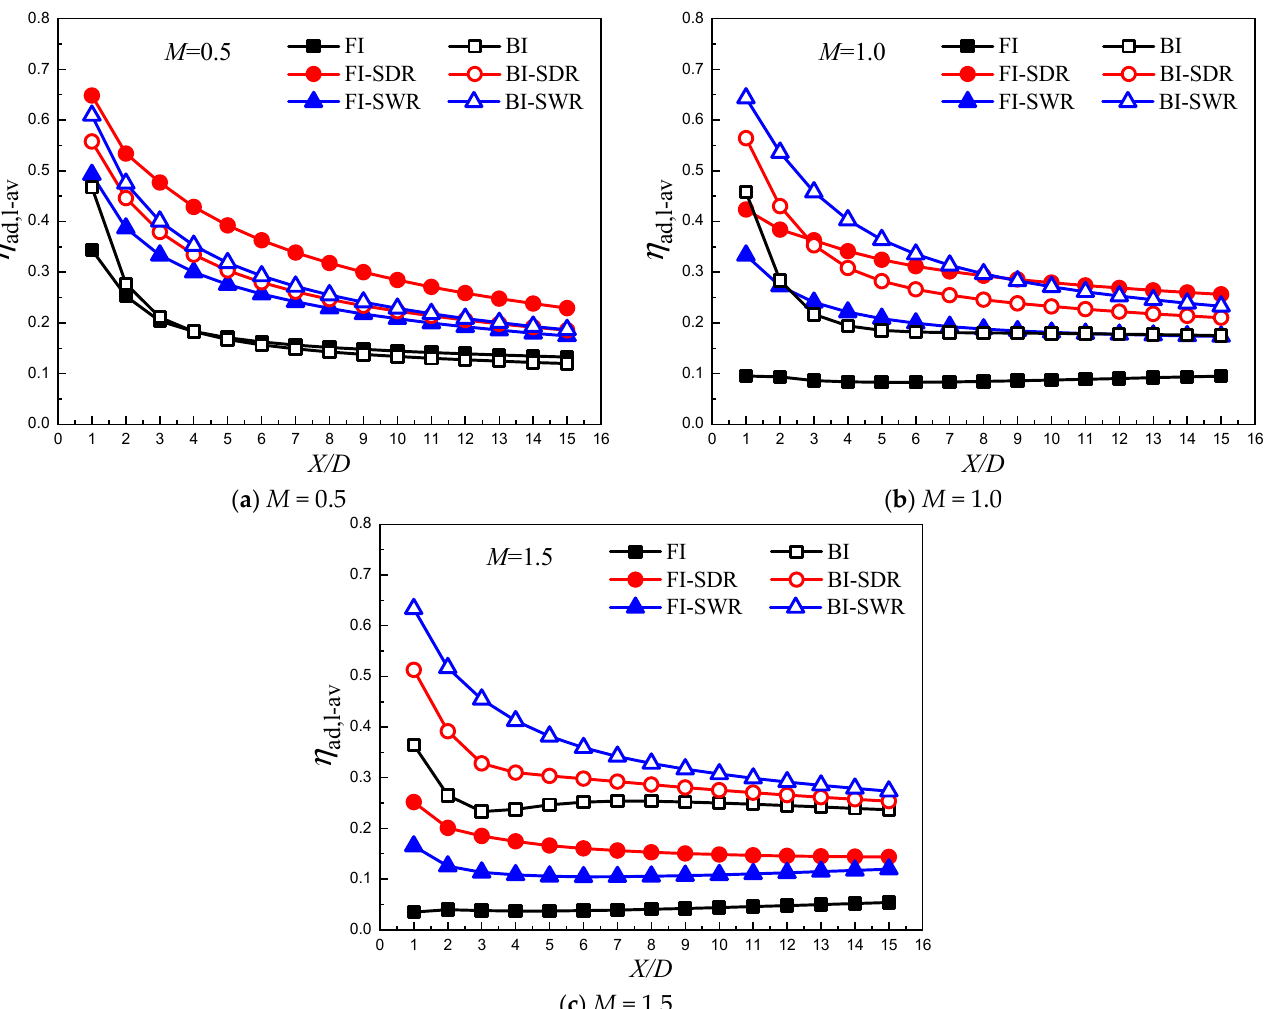
Figure 15. Laterally averaged adiabatic film cooling effectiveness distributions.